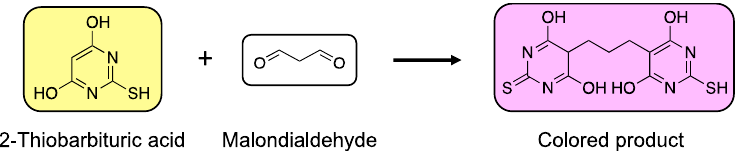
Figure 3. Reaction of 2-thiobarbituric acid (2-TBA) with malondialdehyde (MDA), a biomarker of oxidative stress. 2-TBA reacts with MDA to form a colored product, which is measured spectrophotometrically at 532 nm. The intensity of the colored product reflects the level of lipid peroxidation in the sample.